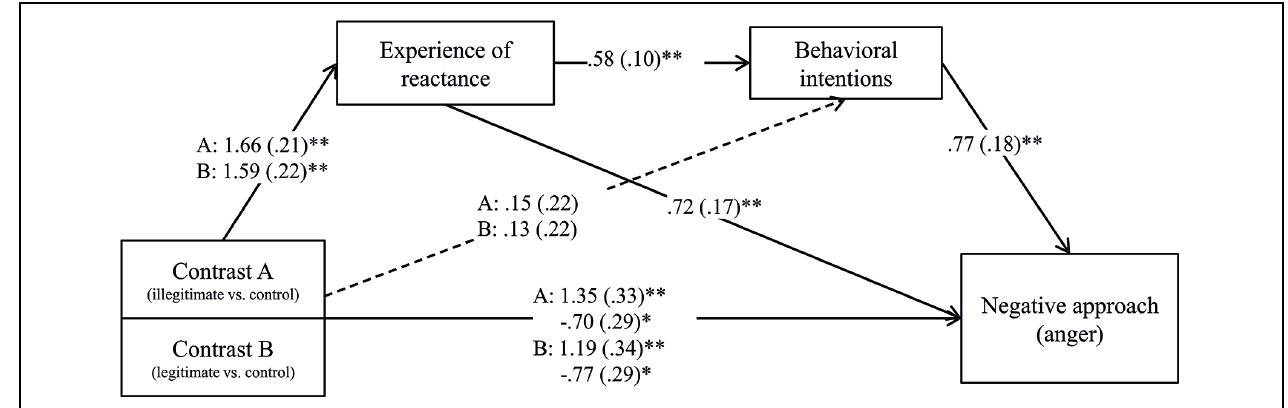
FIGURE 4 | The effect of freedom restrictions on positive approach via experience of reactance and behavioral intentions. ∗ p < 0.05, ∗∗ p <